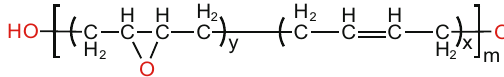
Figure 7: Molecular formula of EHTPB.